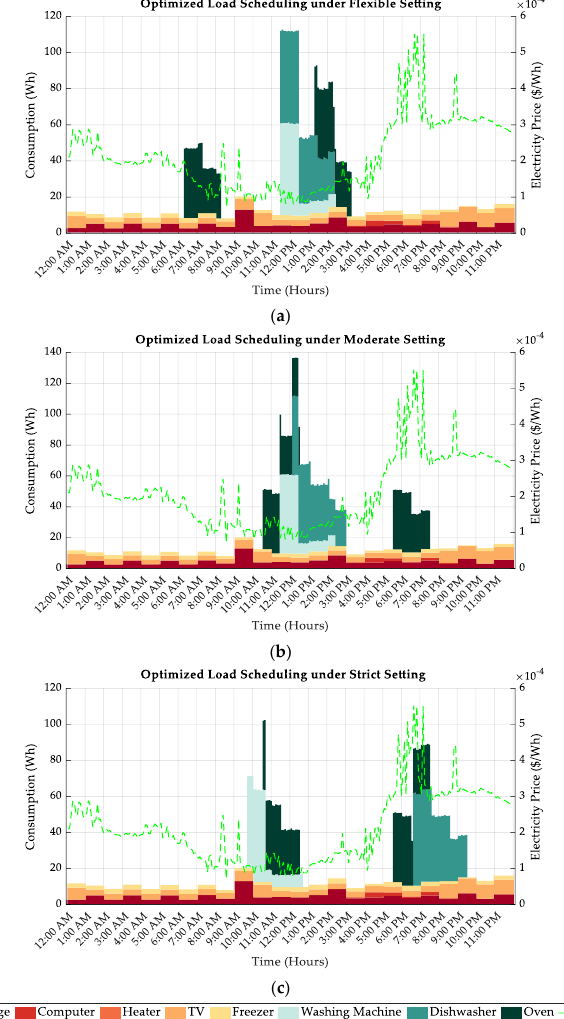
Figure 4. Resulting Load Profiles from Scenario 1. ( a ) Load Scheduling for the Flexible Setting; ( b ) Load Scheduling for the Moderate Setting; ( c ) Load Scheduling for the Strict Setting.